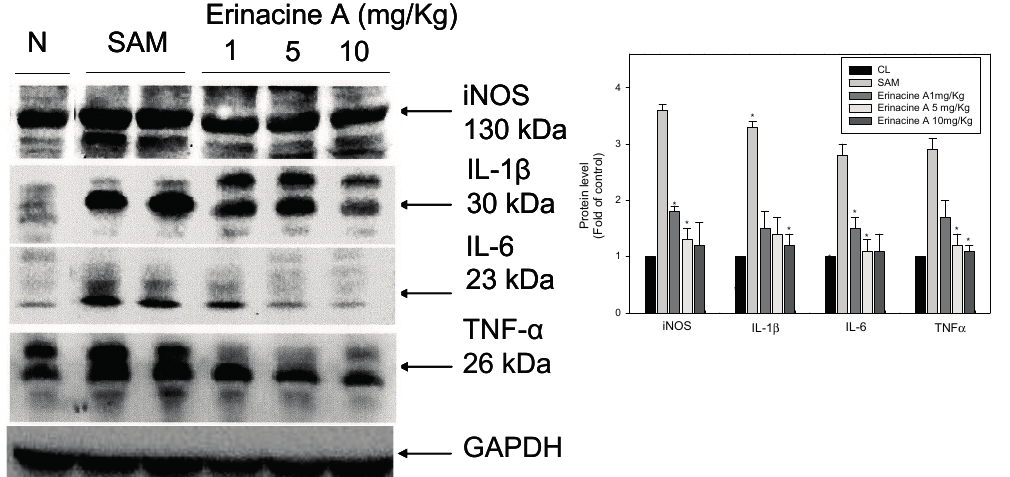
Figure 4. Hericium erinaceus mycelium erinacine A-mediated serum protein expression of acute inflammation cytokines in transient stroke animal model. Rat serum with SAM infusion had high levels of oxidative stress and inflammation. Equal amounts of serum for the indicated treatments were analyzed by SDS-PAGE and subsequently immunoblotted with antisera against iNOS, IL-1, IL-6 and TNF, with GAPDH serving as an internal control. Protein levels were quantified by densitometric analysis with the control being set at 100%. Data are presented as the mean ± SD of 3 independent experiments. * p < 0.05, when compared with the SAM